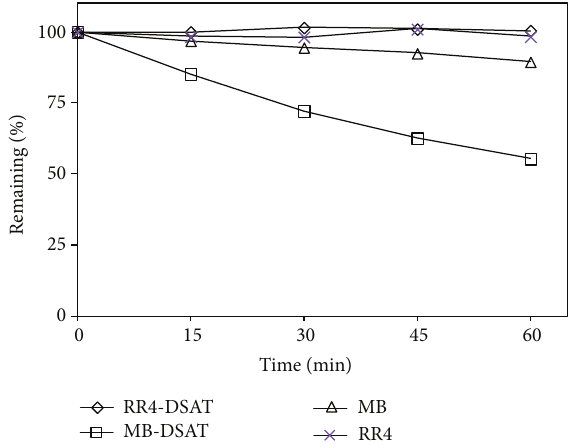
Figure 2: Control tests of RR4 and MB